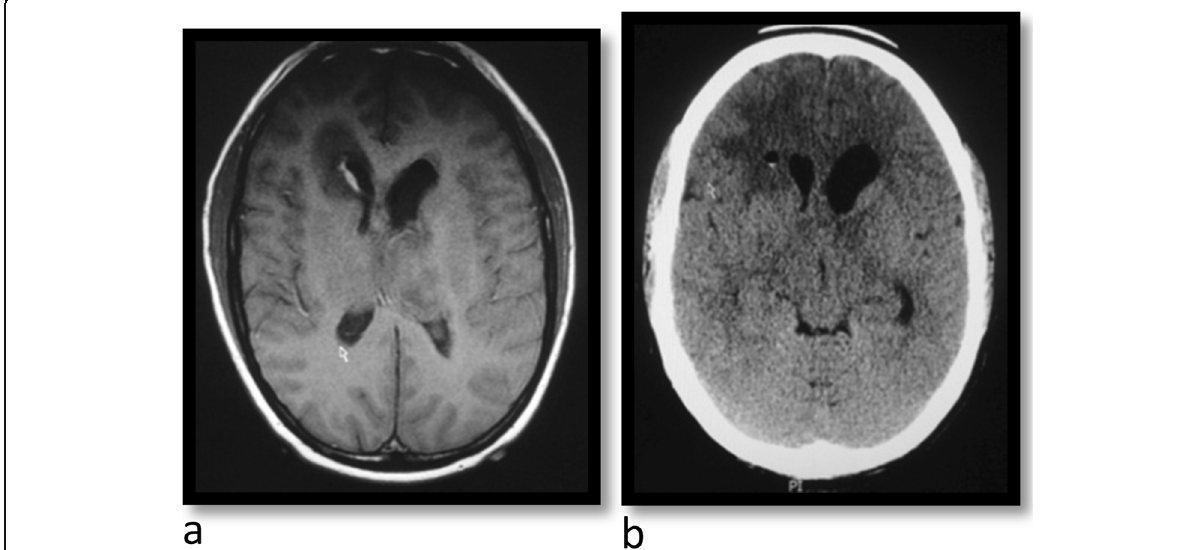
Fig. 12 a On the left showing axial T1 MRI for total thalamic glioma and b on the right shows gross total removal through anterior interhemispheric